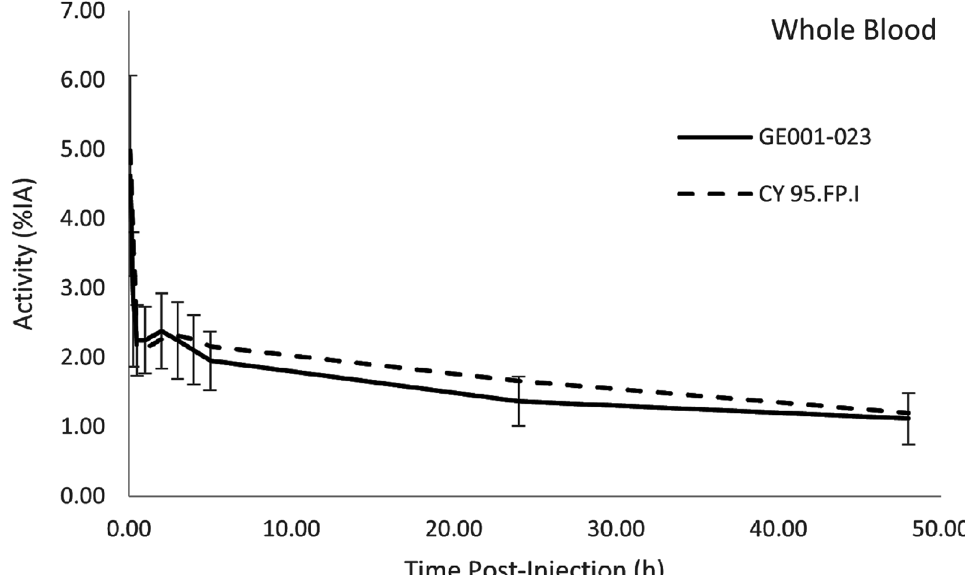
Fig. 1 Mean whole blood. 123 I activity curves in Chinese HVs (solid line, GE001-023, error bars represent one standard deviation.) vs the HVs in a European phase 1 study (dashed line, CY95.FP.1) [8]